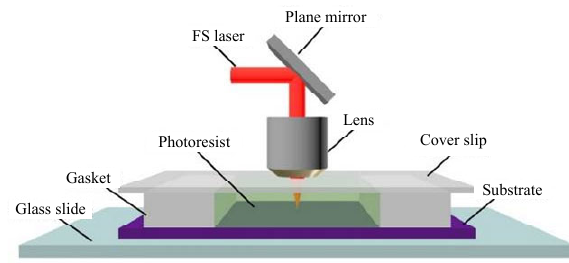
Fig. 2 Micro-machining sample device diagram.